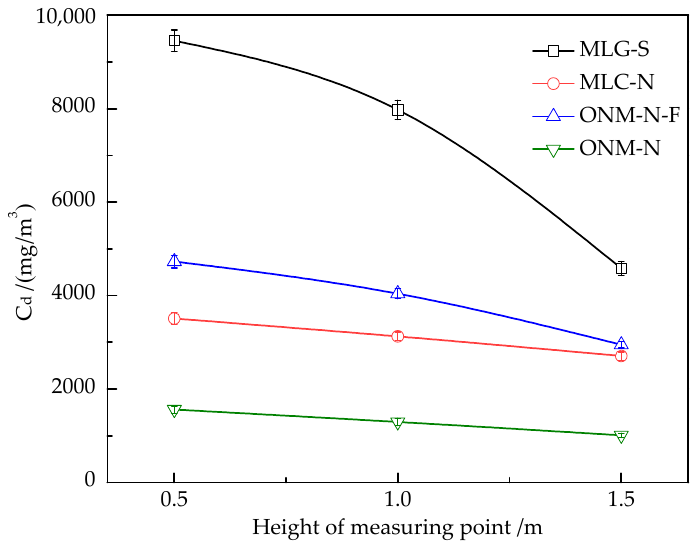
Figure 8. Concentration distribution of dust at different measuring points inside the chute.